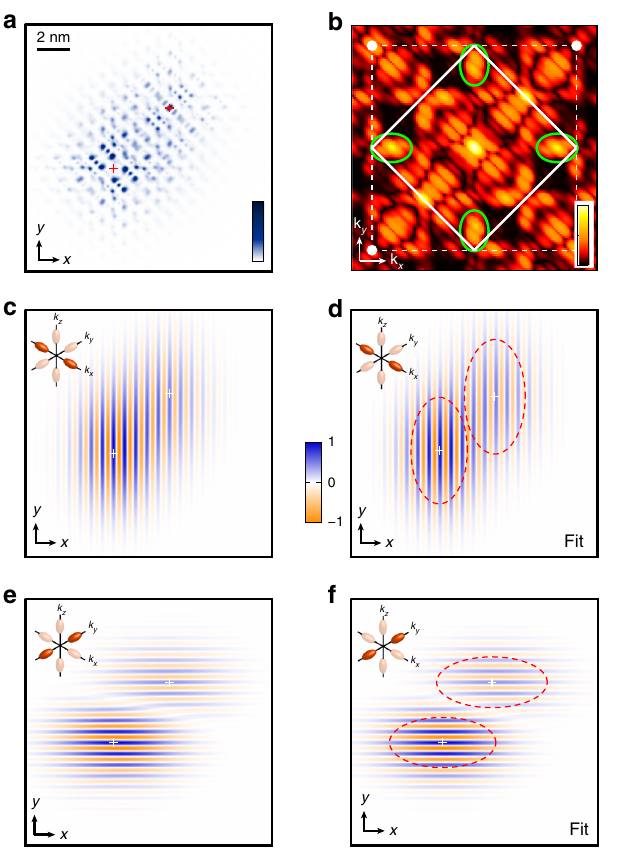
Fig. 3 Theoretical two-electron STM image and valley interference. a Theoretical STM image computed using the pinpointed locations of the two donors and FCI calculations performed to determine the two-electron wavefunctions based on tight-binding one-electron states. b 2D Fourier transform of the STM image focussed on the fi rst Brillouin zone. The valley components at 0.81 k 0 and the diagonal slices highlighting the interference are clearly visible. c Real-space image of the x -valley obtained by fi ltering the FFT around k x ~ 0.81 k 0 . d Corresponding fi tted image, using the same fi tting procedure as for the experimental data, and from which Δ ϕ ratio b / a for each donor (red dashed ellipsoids) can be extracted. As for the experiment, the x -valleys are found to be in-phase. e , f Same for the y - valleys, which like for the experiment are out-of-phase.